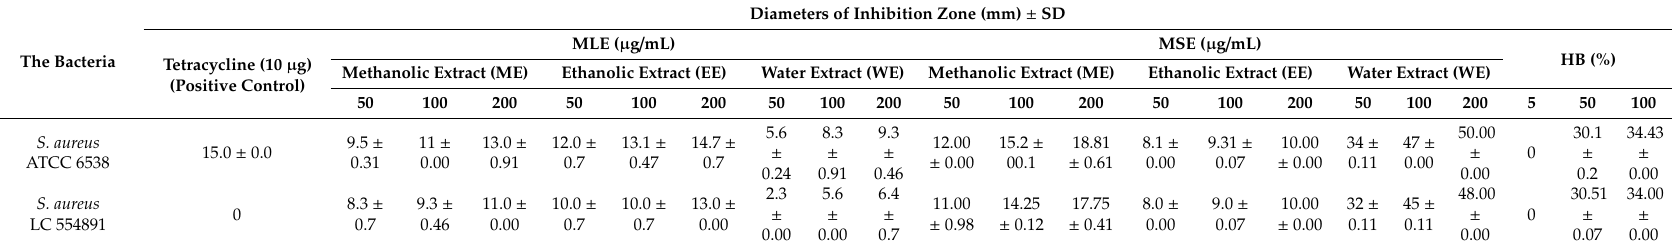
Table 3. Inhibitory activity of both Moringa oleifera extracts (either leaves (MLE) or seeds (MSE) and honey bee (HB) against S. aureus LC